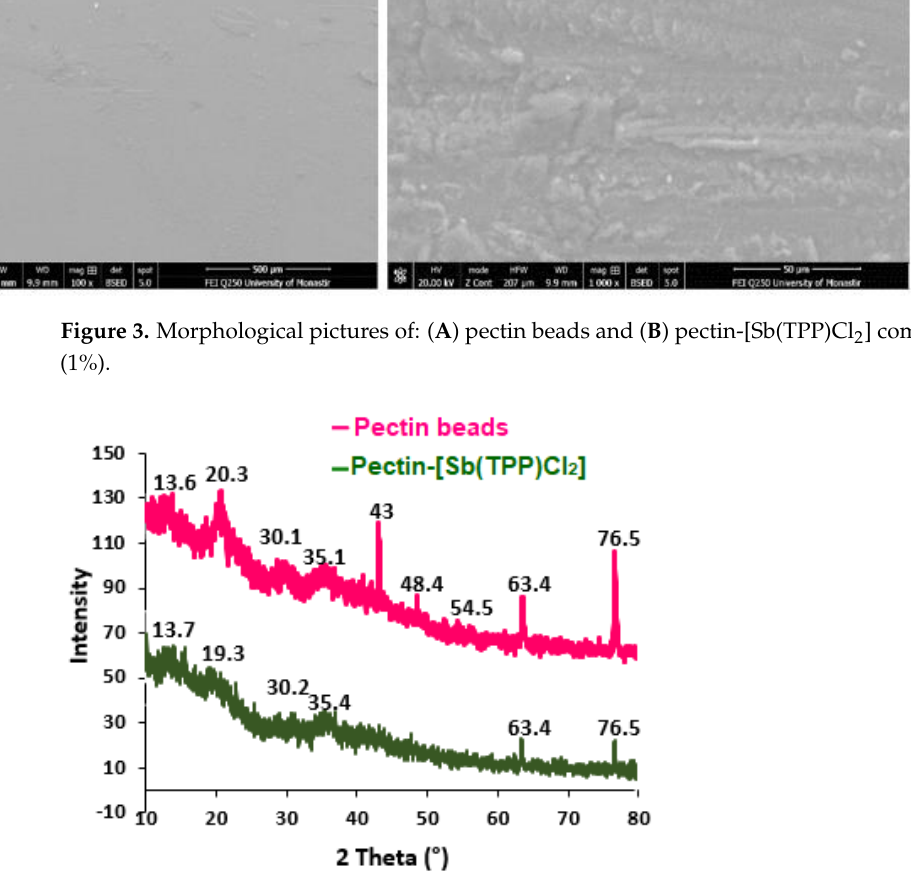
Figure 3. Morphological pictures of: ( A ) pectin beads and ( B ) pectin-[Sb(TPP)Cl 2 ] composite beads (1%).